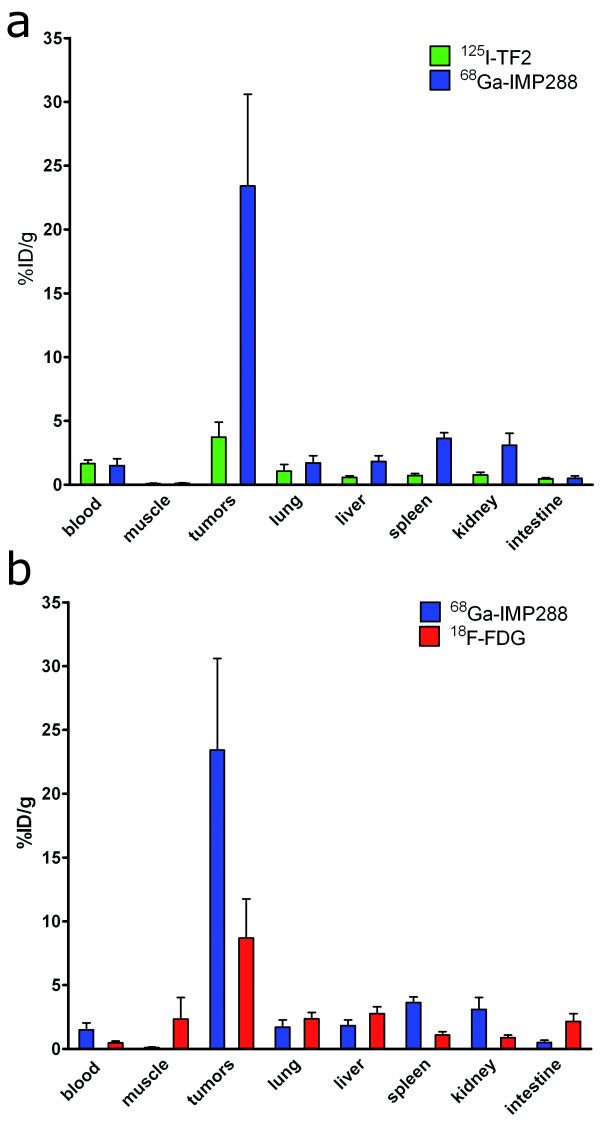
Biodistribution. (a) 6.0 nmol 125I-TF2 (0.37 MBq) and 0.25 nmol 68Ga-IMP288 (5 MBq) 1 h after i.v. injection of 68Ga-IMP288 in BALB/c nude mice with intraperitoneal CEA-expressing LS174T tumors. (b) 0.25 nmol 68Ga-IMP288 (5 MBq) and 18F-FDG (5 MBq) 1 h after i.v. injection in the BALB/c nude mice with intraperitoneal CEA-expressing LS174T tumors. Values are given as means ± standard deviation (n = 5).